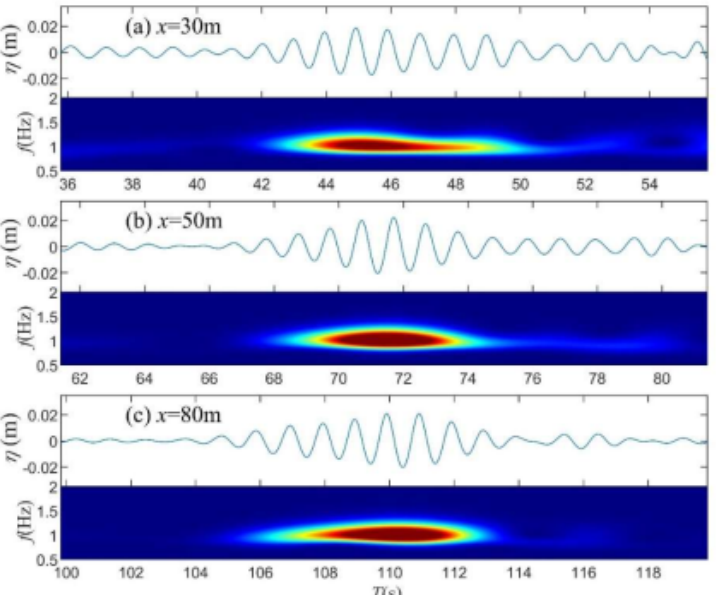
Figure 12. The time series and corresponding wavelet spectrum for Soliton 1 at three locations: